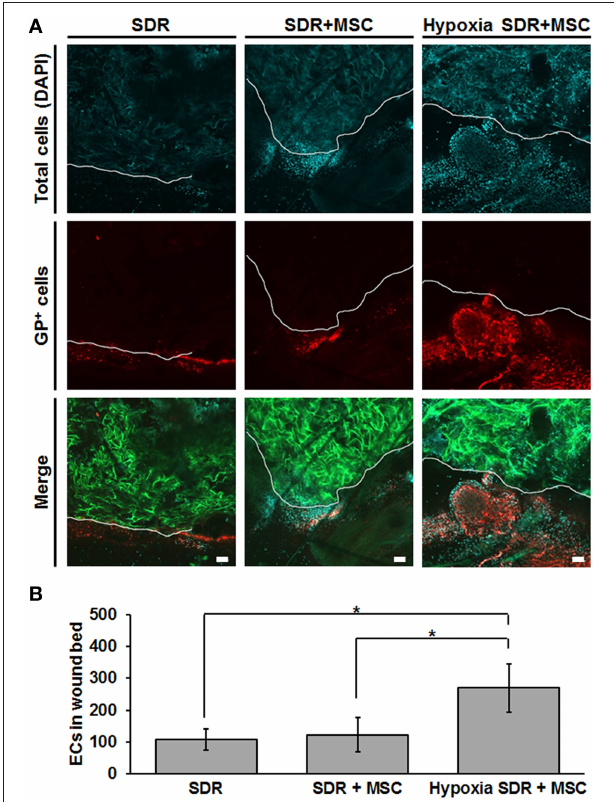
FIGURE 5 | Hypoxic pre-conditioning of MSC-containing SDR favors high cellular infiltration in vivo . MSC-containing SDR were cultured under normoxic or hypoxic conditions for 2 days and then implanted into immune deficient NSG mice, following a skin excision procedure. After 2 weeks, animals were euthanized and scaffold and surrounding tissue were analyzed using laser scanning confocal microscopy. (A) Green shows the SDR (due to auto-fluorescence of collagen), blue shows DAPI staining of cell nuclei, and red shows the staining of GSLI isolectin B4 which binds to the terminal α -D-galactosyl residues of the glycoprotein laminin (GP) expressed by endothelial cells within the basal lamina of neovascular structures. The white line indicates the border of the scaffold and surrounding tissue. (B) Quantification of endothelial cells (ECs), as determined by the average number of GP-positive cells within the first 200 µ m of SDR near wound edge. Scale bar represents 50 µ m. * p < 0.05 .